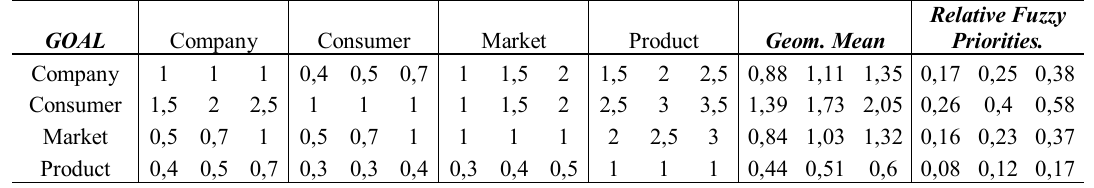
Table 7. Pairwise comparisons and relative fuzzy weights for the criteria.